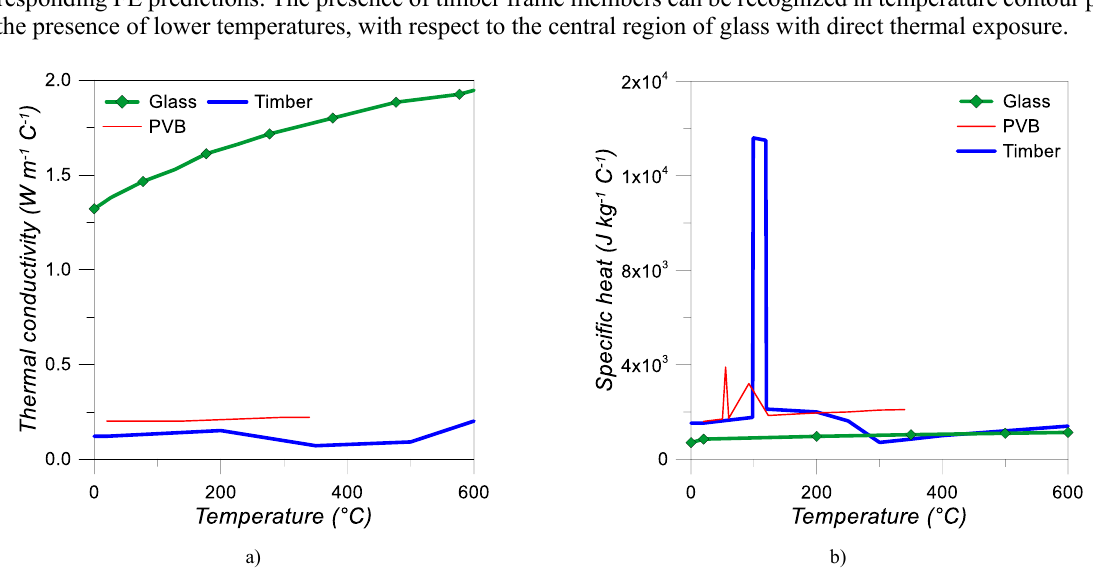
Fig. 6 Thermo-physical characterization of glass, PVB and timber: a) conductivity and b) specific heat.